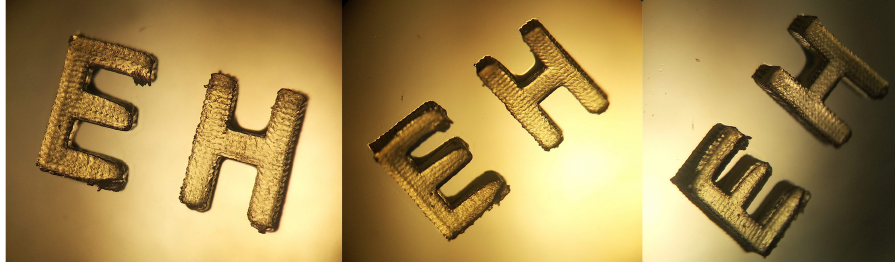
Figure 11. The pattern obtained after the 3D printing experiment based on formulation with T1 (0.07% w / w ) and TMPTA.